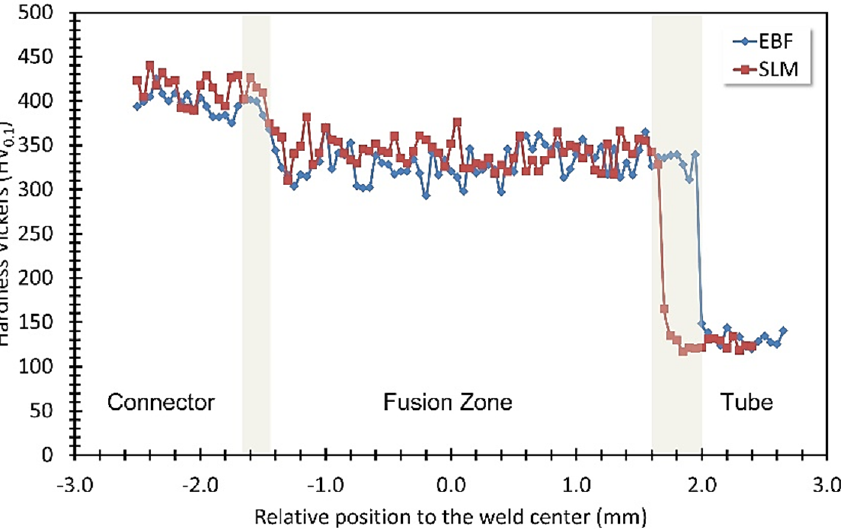
Figure 6. Vickers hardness values as a function of the weld center distance for SLM and EBM cases. Each region is noted at bottom.